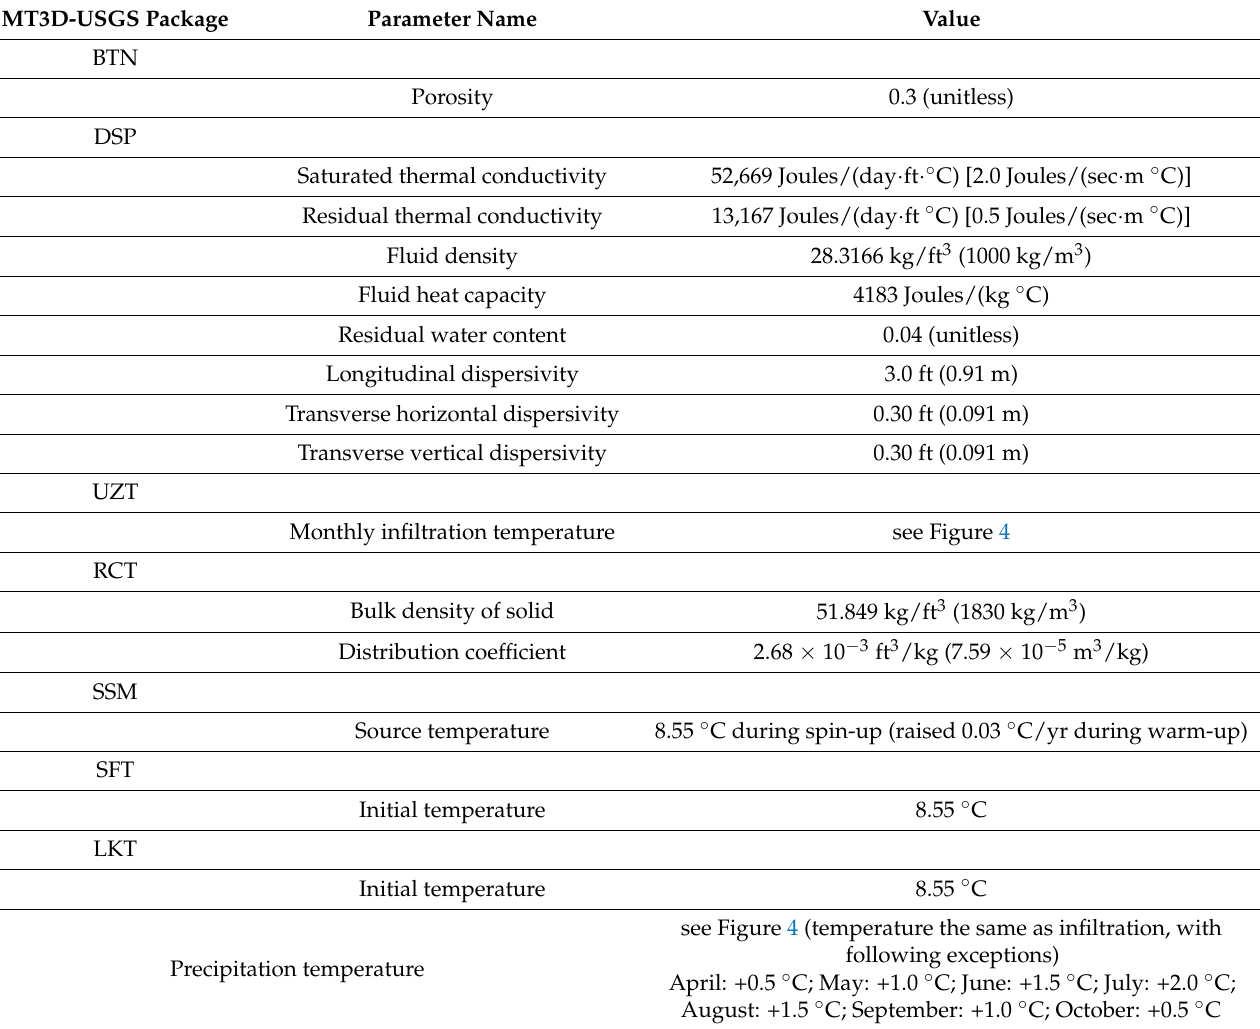
Table 2. Transport parameter values for synthetic watershed model, spatially homogeneous.